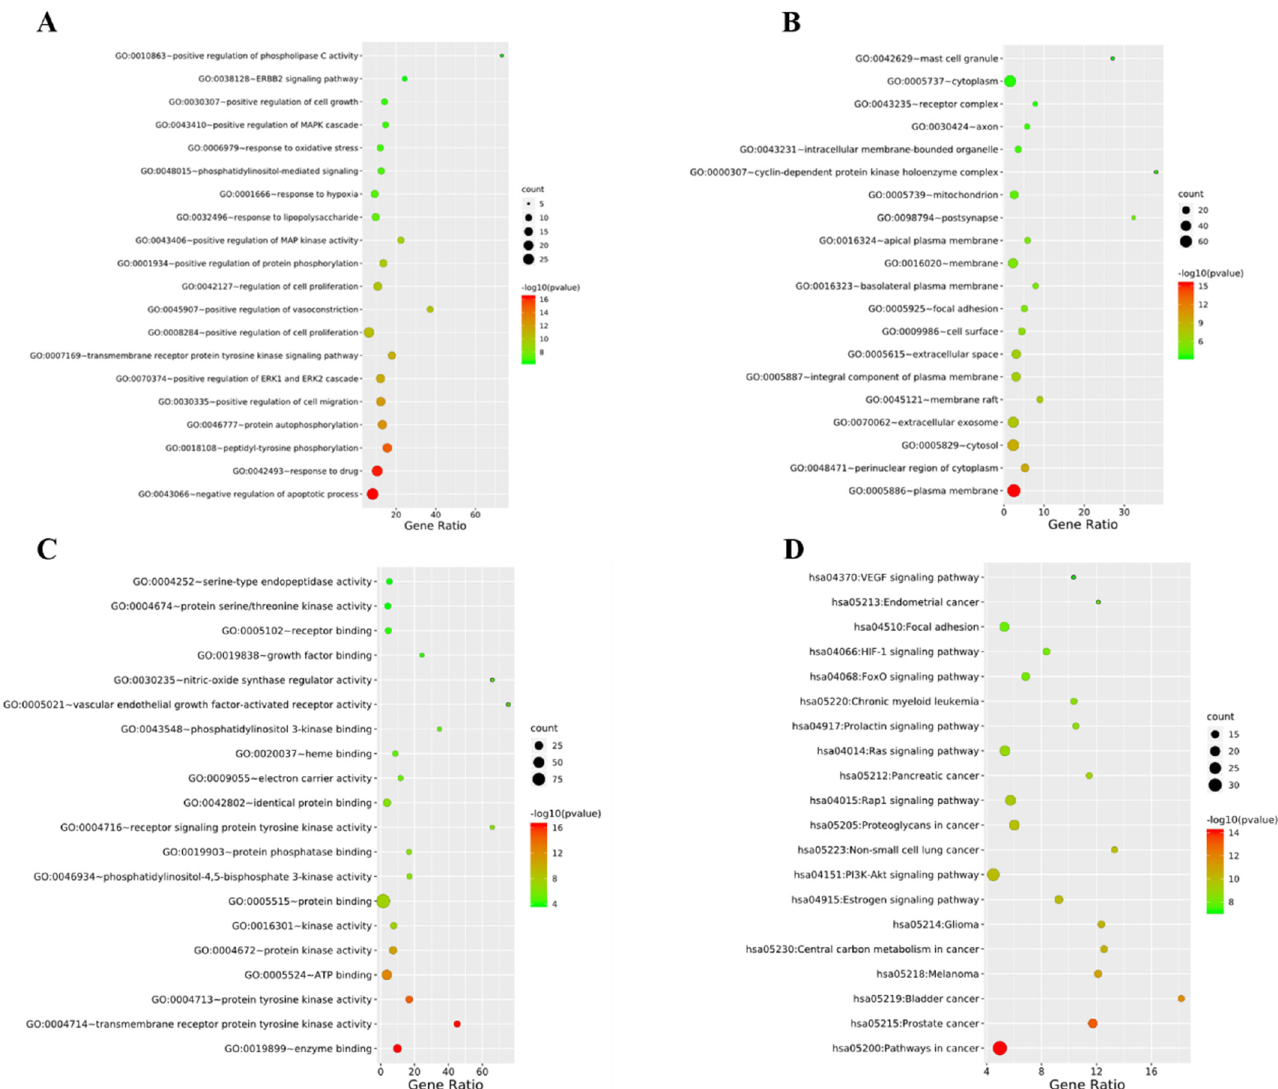
Figure 4. Biological process ( A ), molecular function ( B ), action target ( C ) and involved pathway ( D ) that may be involved in the effect of MH on regulating blood glucose.